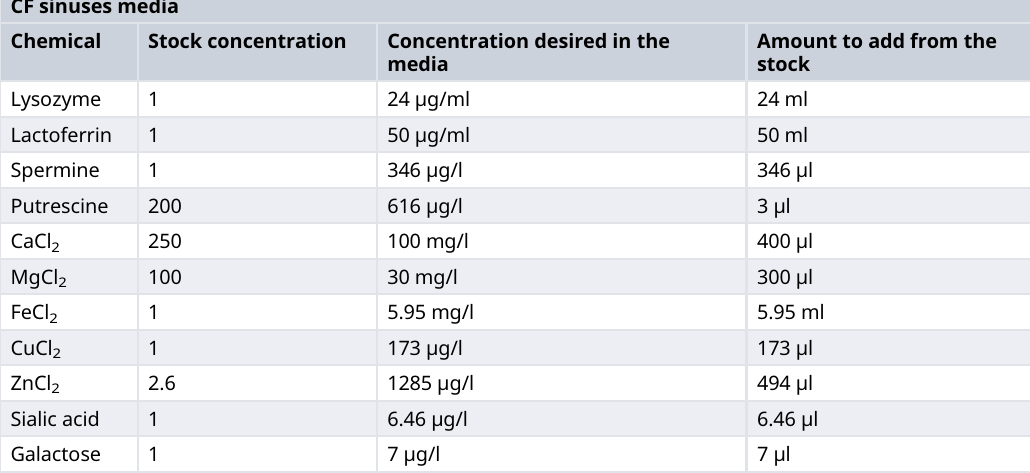
Table 6. Volume of each chemical to add into the base media for 1liter